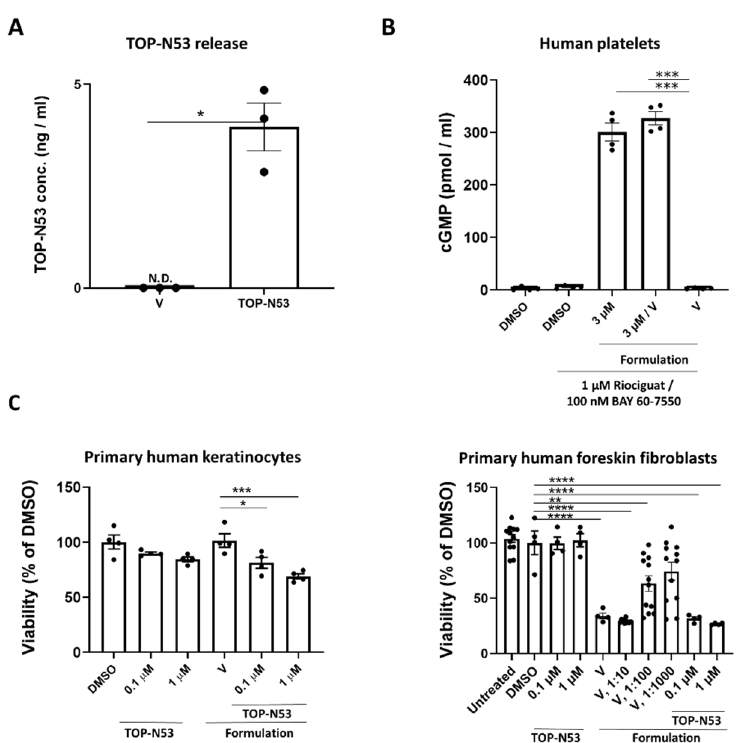
Figure 1. A non-toxic liquid hydrogel formulation allows release of active TOP-N53. ( A ) TOP-N53 concentration as measured by LCMS multiple reaction monitoring in human blood plasma diluted with simulated interstitial fluid buffer (1:1) following 24 h incubation in a rapid equilibrium dialysis device system. N = 3 per treatment group. N.D.: not detectable; V: Vehicle. ( B ) Washed human platelets were incubated with riociguat (1 µ M) and BAY 60-7550 (100 nM) for 10 min and then treated with 3 µ M of TOP-N53 hydrogel formulation or vehicle hydrogel formulation (V) or vehicle hydrogel formulation and 3 µ M of TOP-N53 dissolved in DMSO for 2 h. Incubation was terminated by adding 20 µ L of 2 N HCl. Total cGMP (pmol/mL) was measured by ELISA. N = 4 independent experiments using platelets from different donors. Primary human keratinocytes (( C ), left) or foreskin fibroblasts (( C ), right) were incubated for 22–24 h with 0.1 or 1 µ M TOP-N53 in DMSO (0.01%) or 0.01% DMSO only, or with vehicle liquid hydrogel formulation (V) or TOP-N53 at final concentrations of 0.1 or 1 µ M in liquid hydrogel formulation or with 10-, 100- or 1000-fold dilutions of the liquid hydrogel formulation in culture medium as indicated and analyzed for cell viability using MTT assay. N = 4–12 technical replicates per treatment group. Bars indicate mean +/ − SEM. * p ≤ 0.05, ** p ≤ 0.01, *** p ≤ 0.001, **** p ≤ 0.0001 (Ordinary one-way ANOVA, one sample t test for data shown in Figure